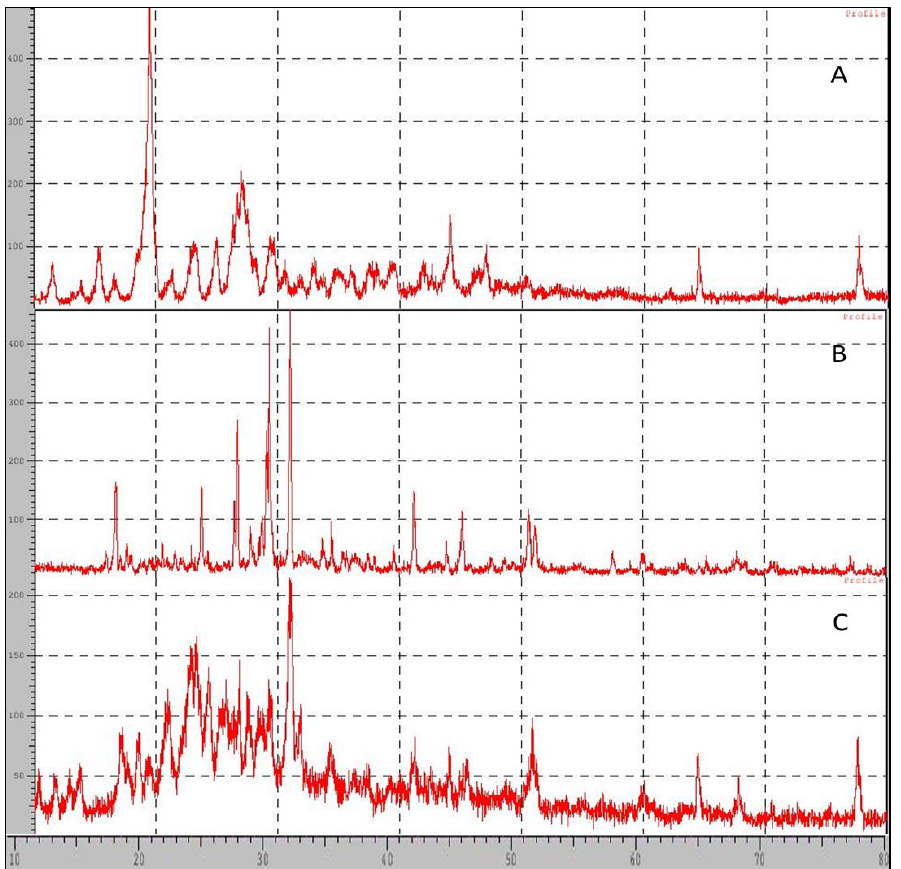
Figure 7. X-RD pattern of ( A ) Pure drug ( B ) β— TCP, ( C ) Nanocarriers (F1).